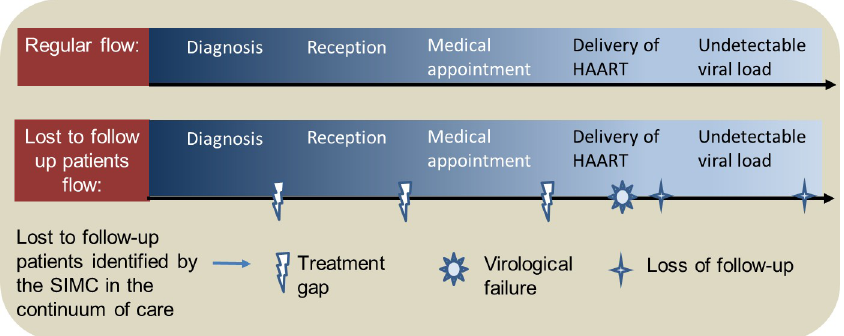
Fig 3. The regular assistance flow and lost to follow-up flow of PLHIV in the continuum of care identified by the SIMC.